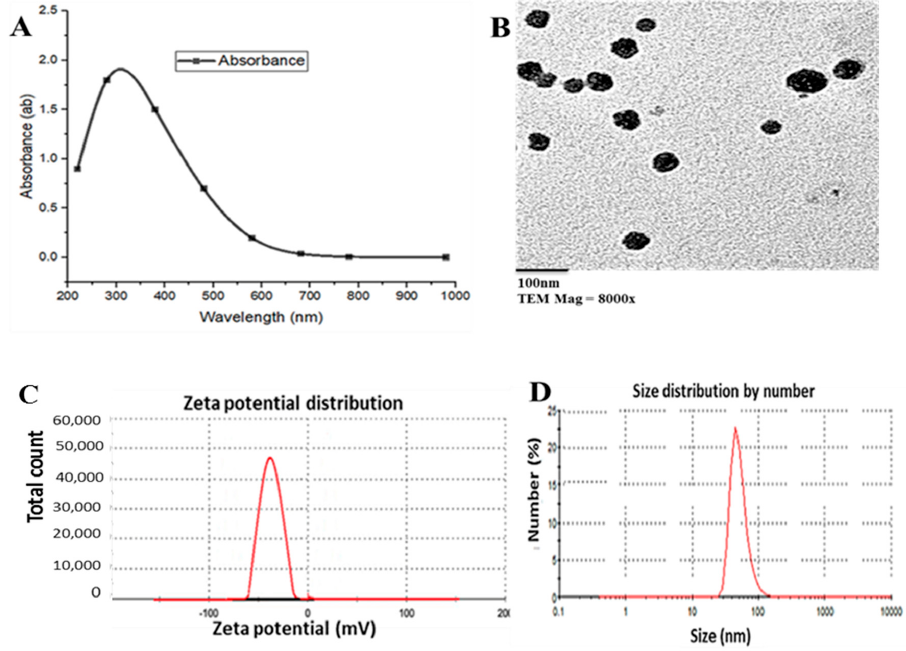
Figure 2. Characterization of QNPs. ( A ) UV–Vis spectroscopy results show the maximum peak at 310 nm, ( B ) TEM analysis reveals a spherical shape with an average size of 45–65 nm, ( C ) zeta potential analysis shows a net surface charge of − 23 mV, ( D ) the DLS analysis shows a hydrodynamic size of 77 nm.